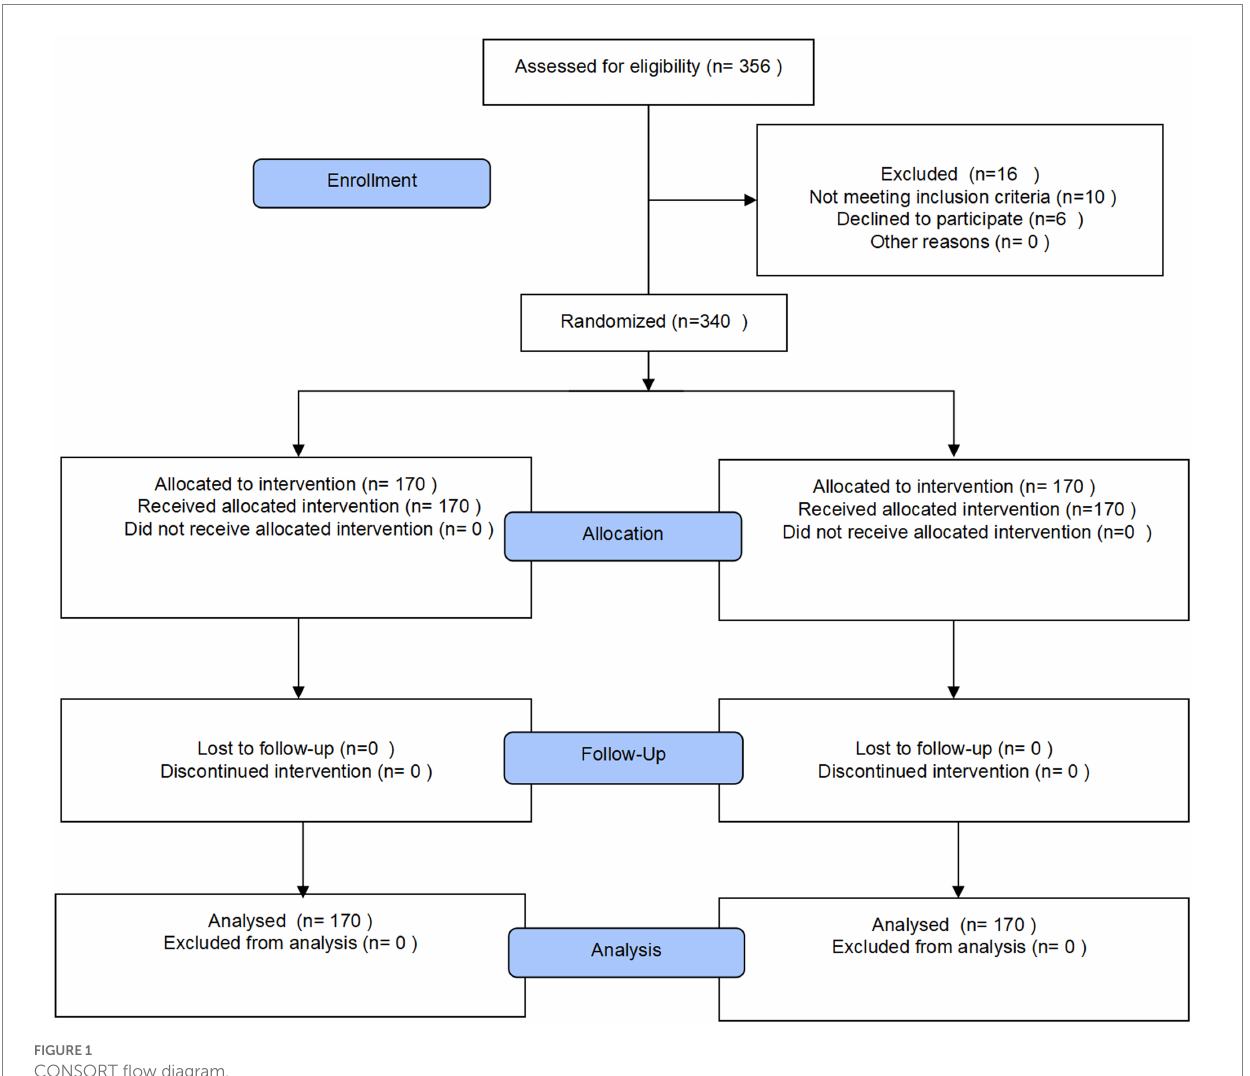
FIGURE 1 CONSORT flow